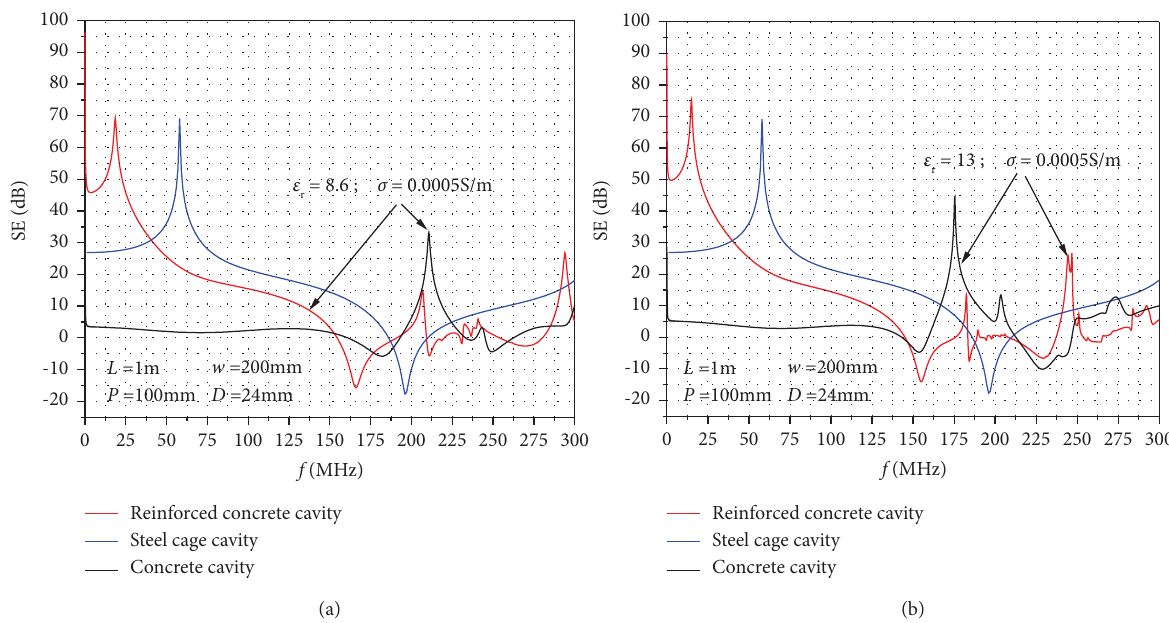
Figure 4: Comparison of shielding efectiveness of three shielding structures under diferent relative permittivity: (a) ε